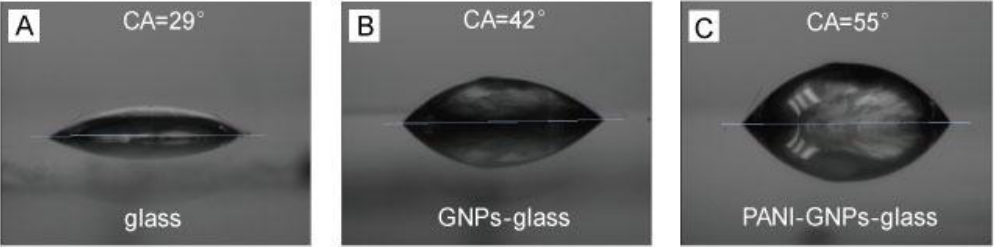
Figure 3. Surface water contact angle (CA) of ( A ) Glass; ( B ) GNPs-glass; and ( C ) PANI-GNPs-glass.